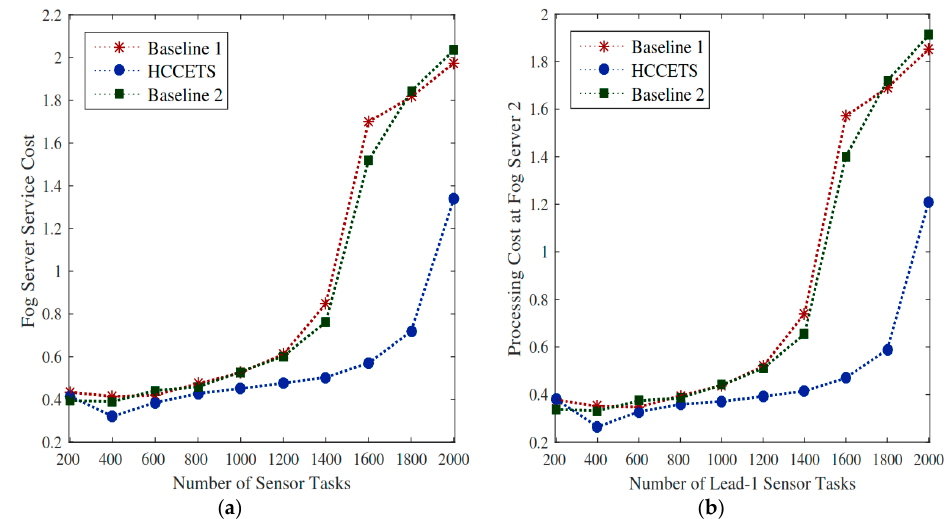
Figure 10. Scheduling of tasks to fog servers. ( a , b ) HCCETS improved system utilization cost as compared to the homogeneous system based Baseline 1 and Baseline 2.